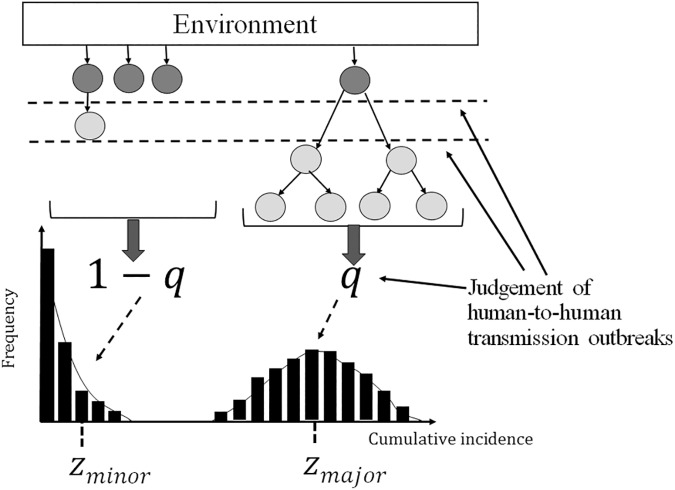
The data-generating process used for investigating norovirus outbreak events.Foodborne cases (dark gray) generate secondary cases via human-to-human transmissions (light gray). Given the final size distribution, let q be the proportion of major epidemics among the total environmental exposures. The expected final sizes of the major and minor outbreaks are expressed as zmajor and zminor, respectively. Judgment of a human-to-human transmission outbreak is considered to have taken place based on the presence of chains of secondary transmissions (i.e. major epidemic), the presence of at least one secondary case, or simply the random sampling result from the final size.